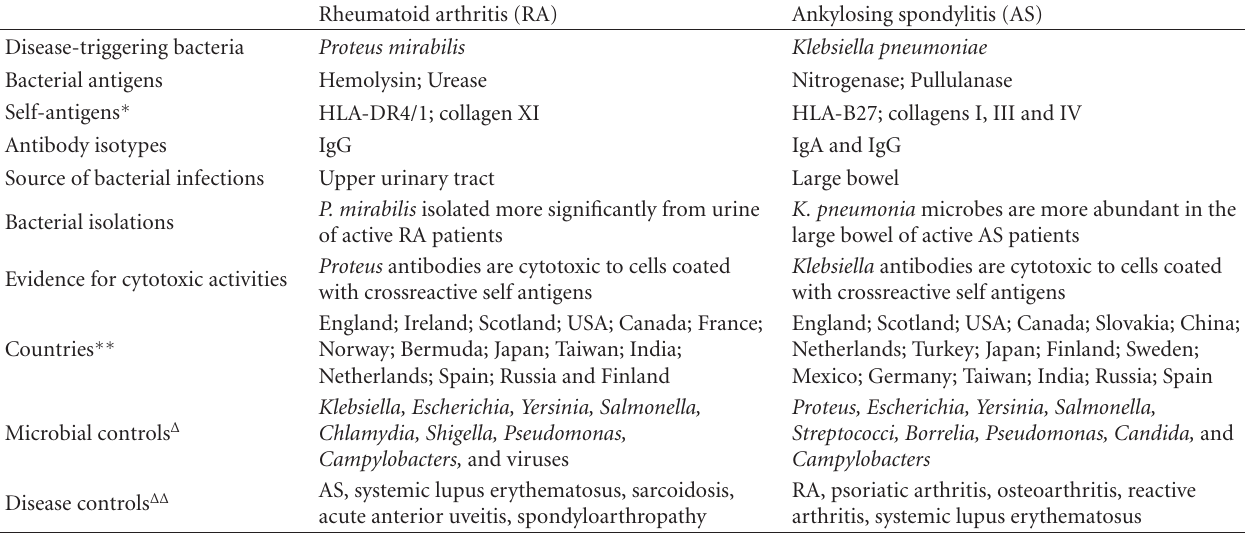
Table 1: Characteristics of bacterial immune responses in patients with rheumatoid arthritis and ankylosing spondylitis (see [33, 34, 41,